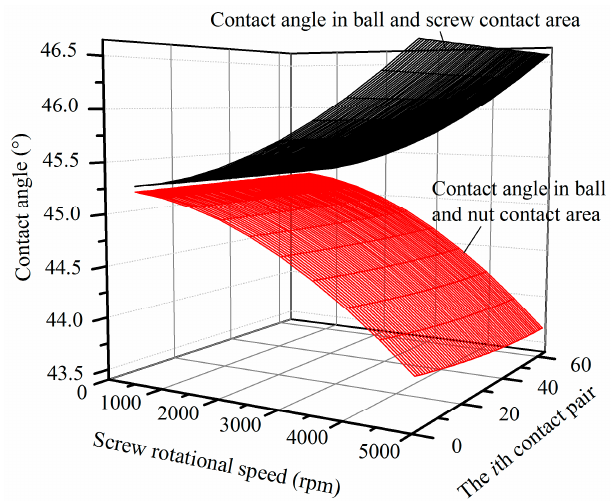
Figure 13. Variation of dynamic contact angle with the contact position and the screw speed.